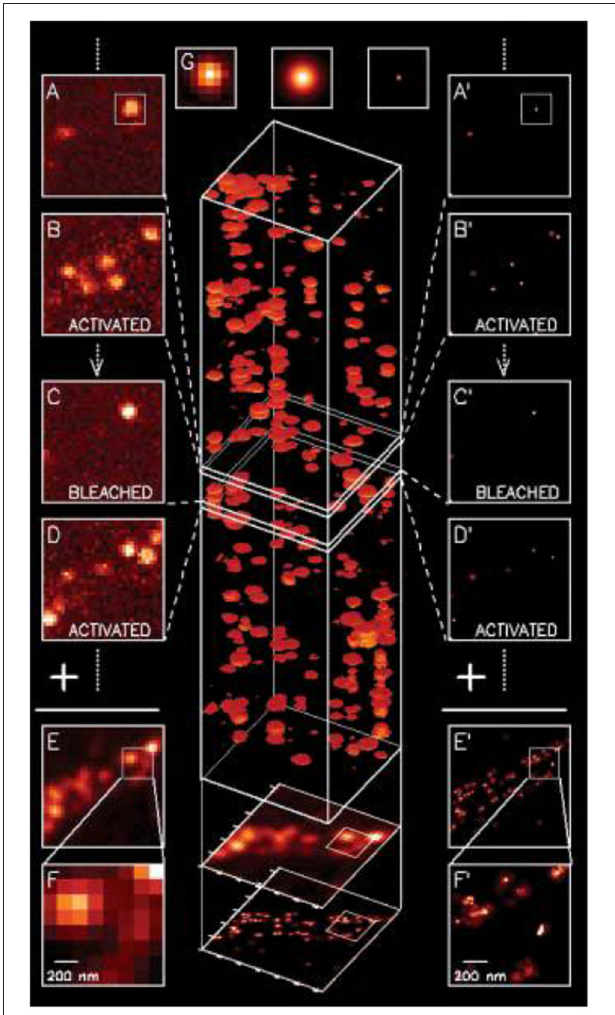
FIGURE 1 | The first SMLM demonstrated with fluorescent proteins in 2006 ( Betzig et al., 2006). A series of diffraction limited images were acquired, and to each image PSF for single emitters were localized with accuracy typically below ∼ 20nm and image reconstructed to form the final image. Copyright with permission from